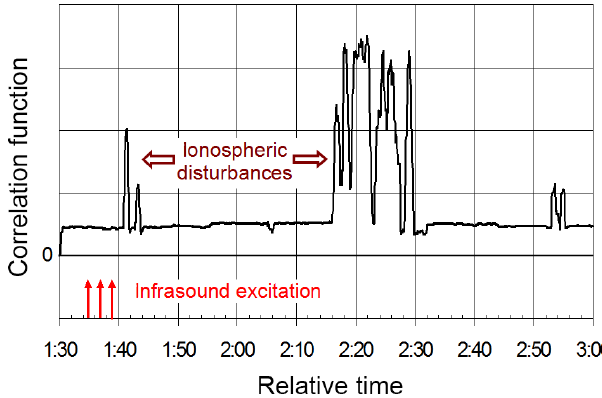
Figure 6. Experimental record of the galactic radio emission has been observed with the correlation radiometer of the HF radio tele- scope URAN-3 at 25MHz (1997). The figure shows a module of the mutual correlation function | r 12 B (t) | between the experimental records of the passed radio emission of a space source registered by the first and second half of the RT URAN-3 antenna in mini- interferometer mode with polarization B (linear horizontal). The group of red arrows represents the time model of acoustic excita- tion. After ∼ 5.5min from the start of the infrasound excitation an increase in intensity of galactic radio background is observed.